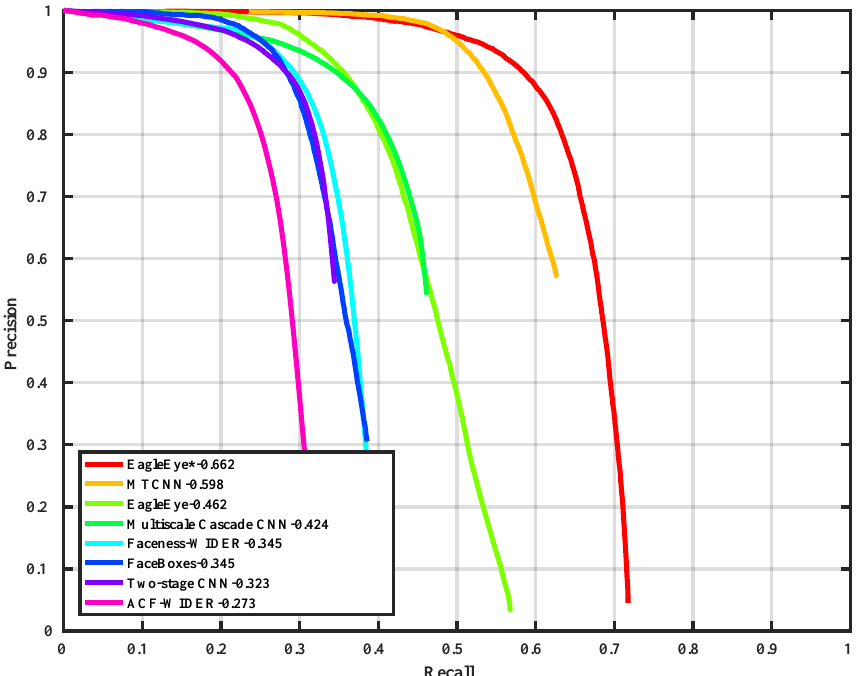
Figure 8. Precision-recall curve on wider face validation (hard)